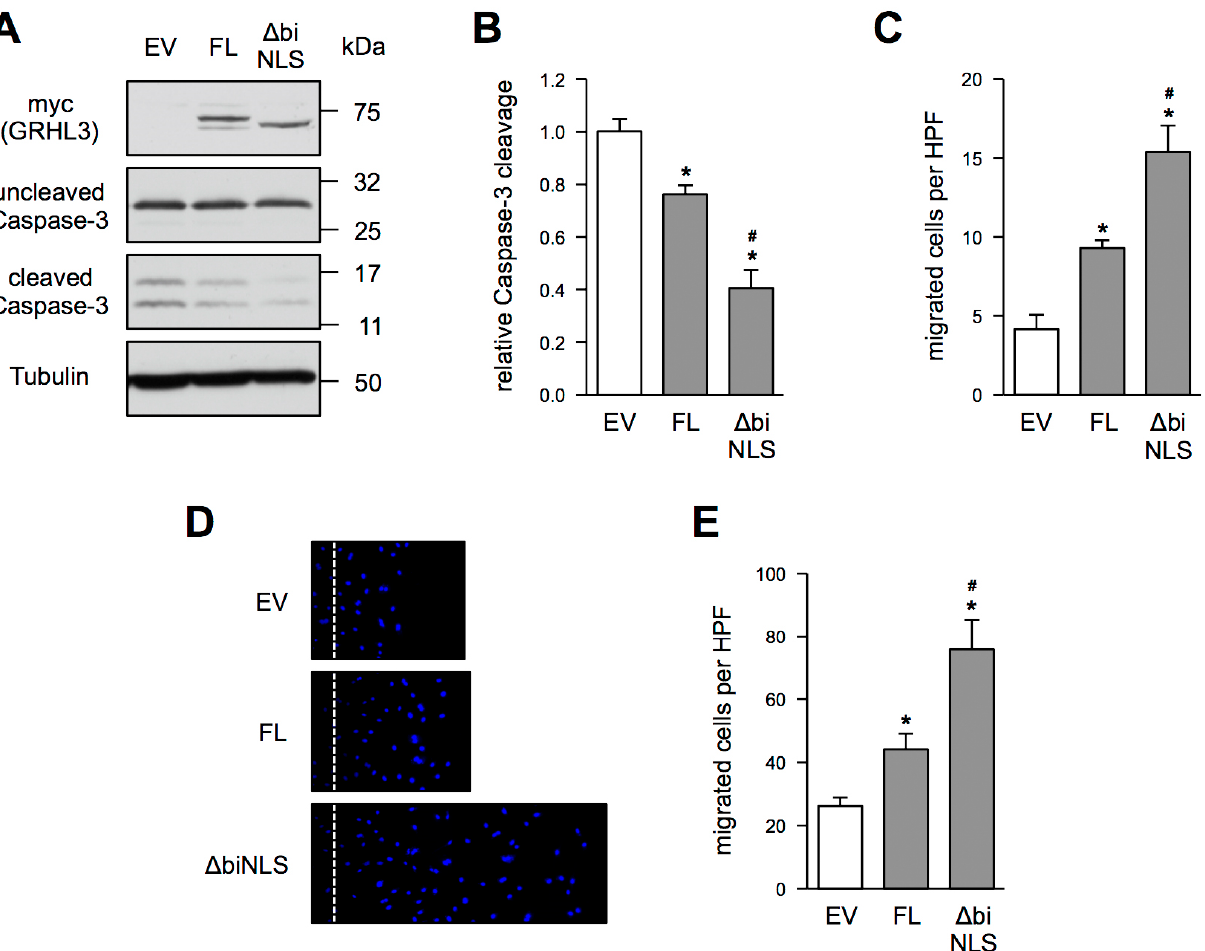
Figure 4. Effects of GRHL3 FL and GRHL3 ∆ biNLS on apoptosis and migration in EC. ( A – E ) EC were transfected with an empty vector (EV), GRHL3 FL or GRHL3 ∆ biNLS plasmids. ( A ) Representative immunoblot. Myc represents the expression of GRHL3 FL, and GRHL3 ∆ biNLS (upper panel), uncleaved Caspase-3 (upper, middle panel), cleaved Caspase-3 (lower, middle panel), Tubulin served as a loading control (lower panel). ( B ) Semiquantitative analyses of the relative amount of cleaved Caspase-3 (data are mean ± SEM, n = 6, * p < 0.05 vs. EV, # p < 0.05 vs. FL). ( C ) Migratory capacity was measured in a Boyden chamber assay. Image J analyses of migrated cells per high-power field (HPF) (data are mean ± SEM, n = 5, * p < 0.05 vs. EV, # p < 0.05 vs. FL). ( D , E ) Migratory capacity was measured in a scratch-wound assay. ( D ) Representative DAPI staining. Wounds were set at the scattered lines; left of the lines are the unwounded areas. The areas right to the lines show the wounds with the cells that had migrated into them. Nuclei were stained with DAPI. ( E ) Image J analyses of migrated cells per high-power field (HPF) (data are mean ± SEM, n = 5, * p < 0.05 vs. EV, # p < 0.05 vs. FL). In agreement with the improved endothelial cell functionality in EC overexpressing GRHL3 ∆ biNLS, this extra-nuclear GRHL3 variant increased the S-NO content